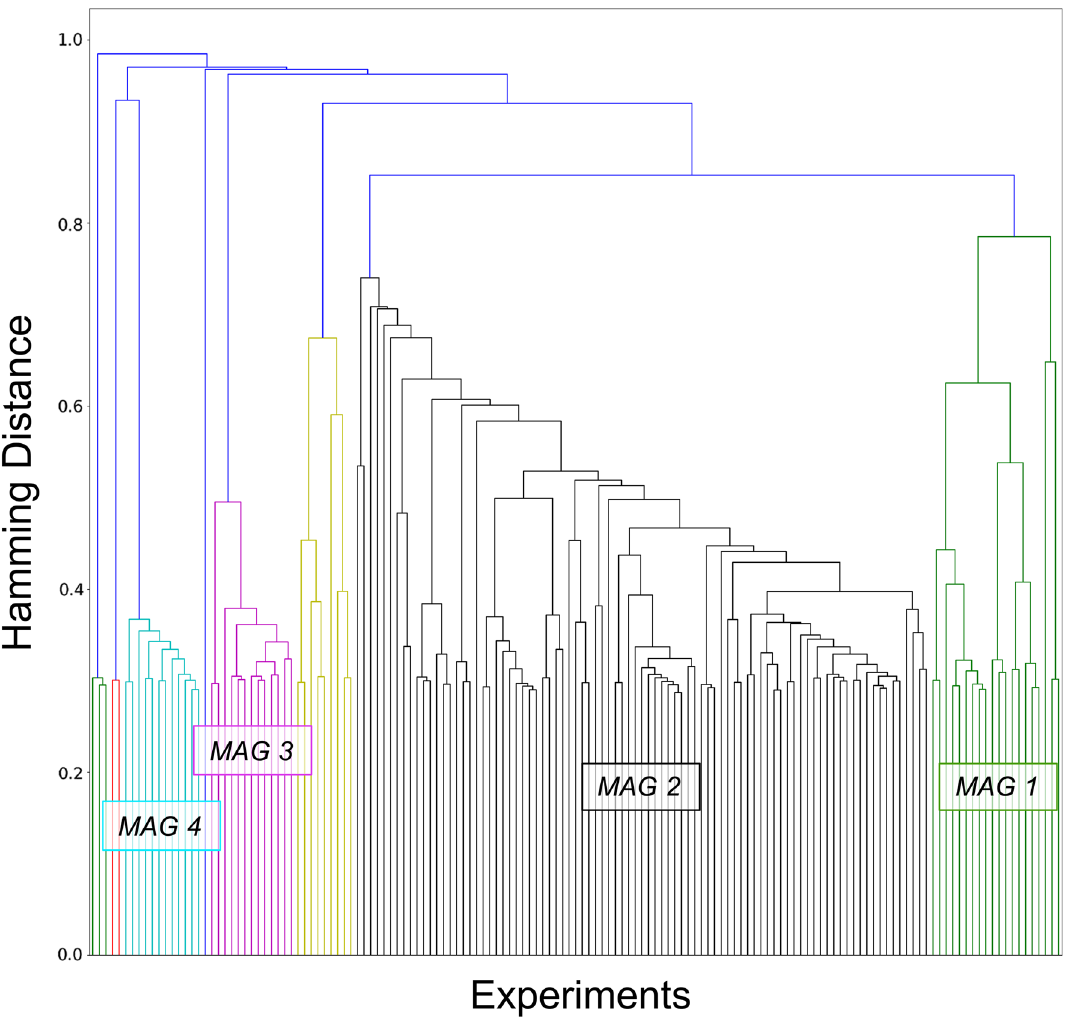
Figure 2. Hierarchical clustering of aberrant activation maps. This dendrogram represents the final hierarchical clustering model which grouped experiment showing similar aberrant activation maps. The 4 significant meta-analytical groupings (MAGs) represented 90.58% of total sample of experiments: MAG1 (green) = 21 experiments and 577 subjects; MAG2 (black) = 87 experiments (1848 subjects); MAG3 = 13 experiments (197 subjects) & MAG4 (cyan) = 12 experiments (278